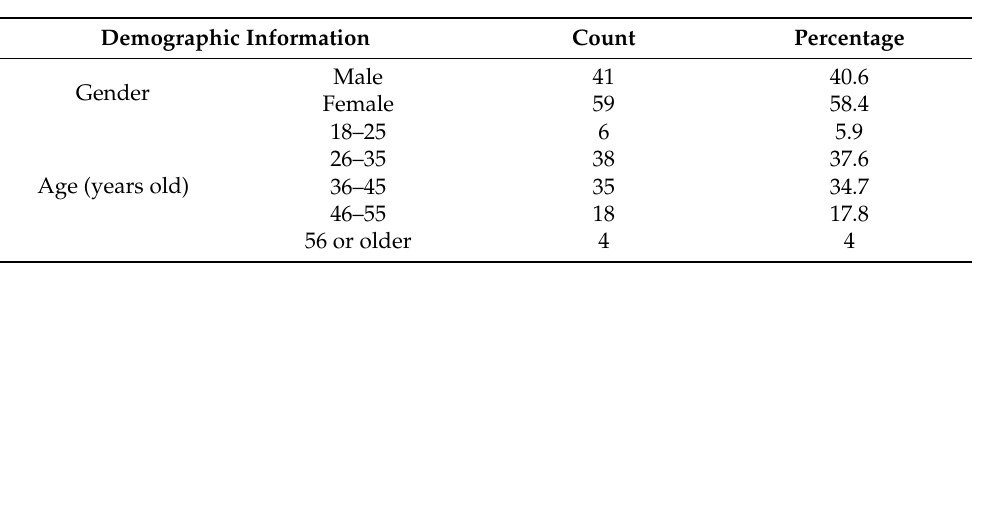
Table 1. Detailed demographics of emergency department workers that participated in the online survey investigating the impact of stressors during the COVID-19